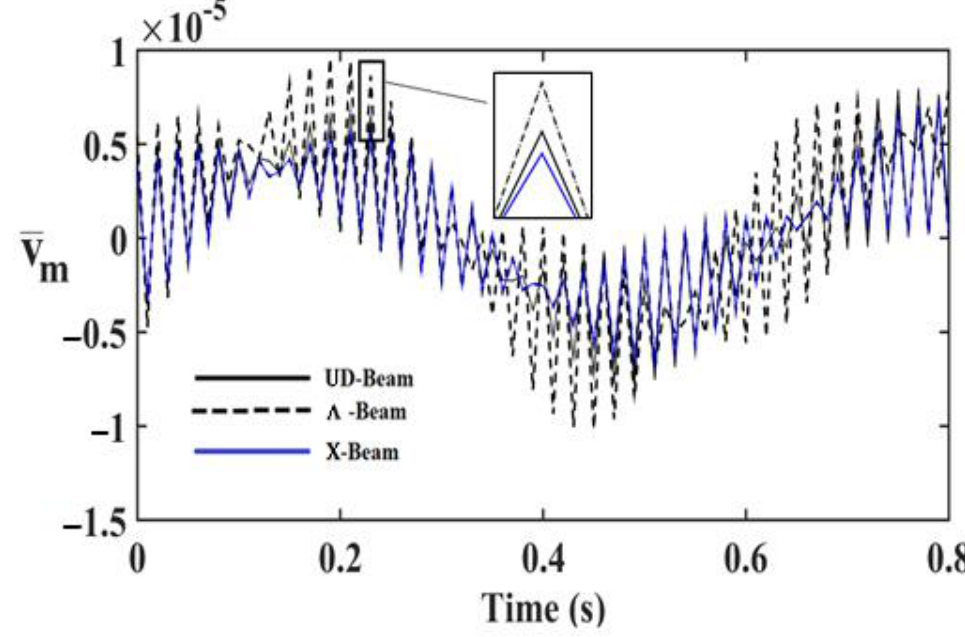
Figure 2. Time responses of the CNTRC beam with different reinforcement patterns for V CNT = 0.12.